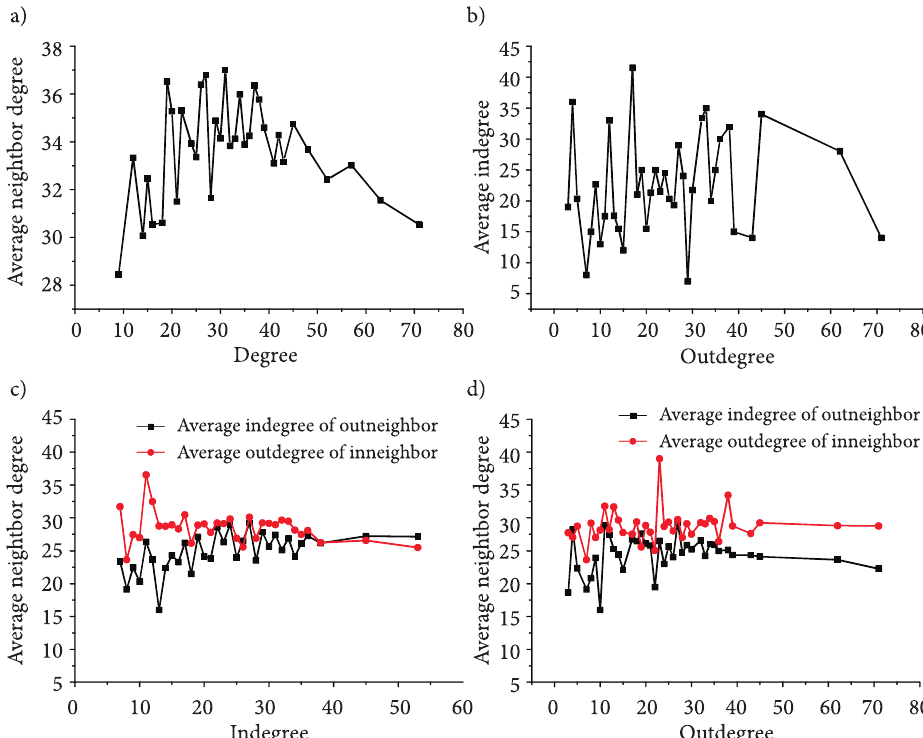
Fig. 3. Degree of correlation of the discipline knowledge network. (a) degree correlation of network S ; (b) correlation of in-degree and out-degree in network W ; (c) correlation of the in-degree of a node and its in-neighbour’s average out-degree in network W ; (d) and correlation between the out-degree of a node and its out-neighbour’s average in-degree in network